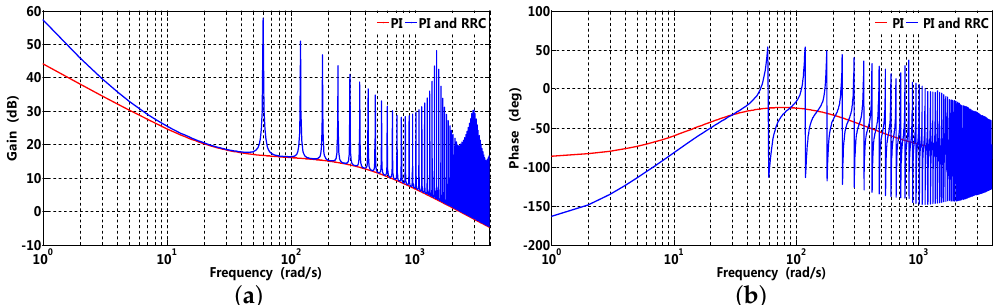
Figure 8. Gain and phase waveforms of q -axis current open-loop transfer function, where corresponding parameters are N = 1044, ω 0 = 60 rad/s, p = 3, D = 2.6 and T s = 0.1 ms, respectively. ( a ) gain; ( b )